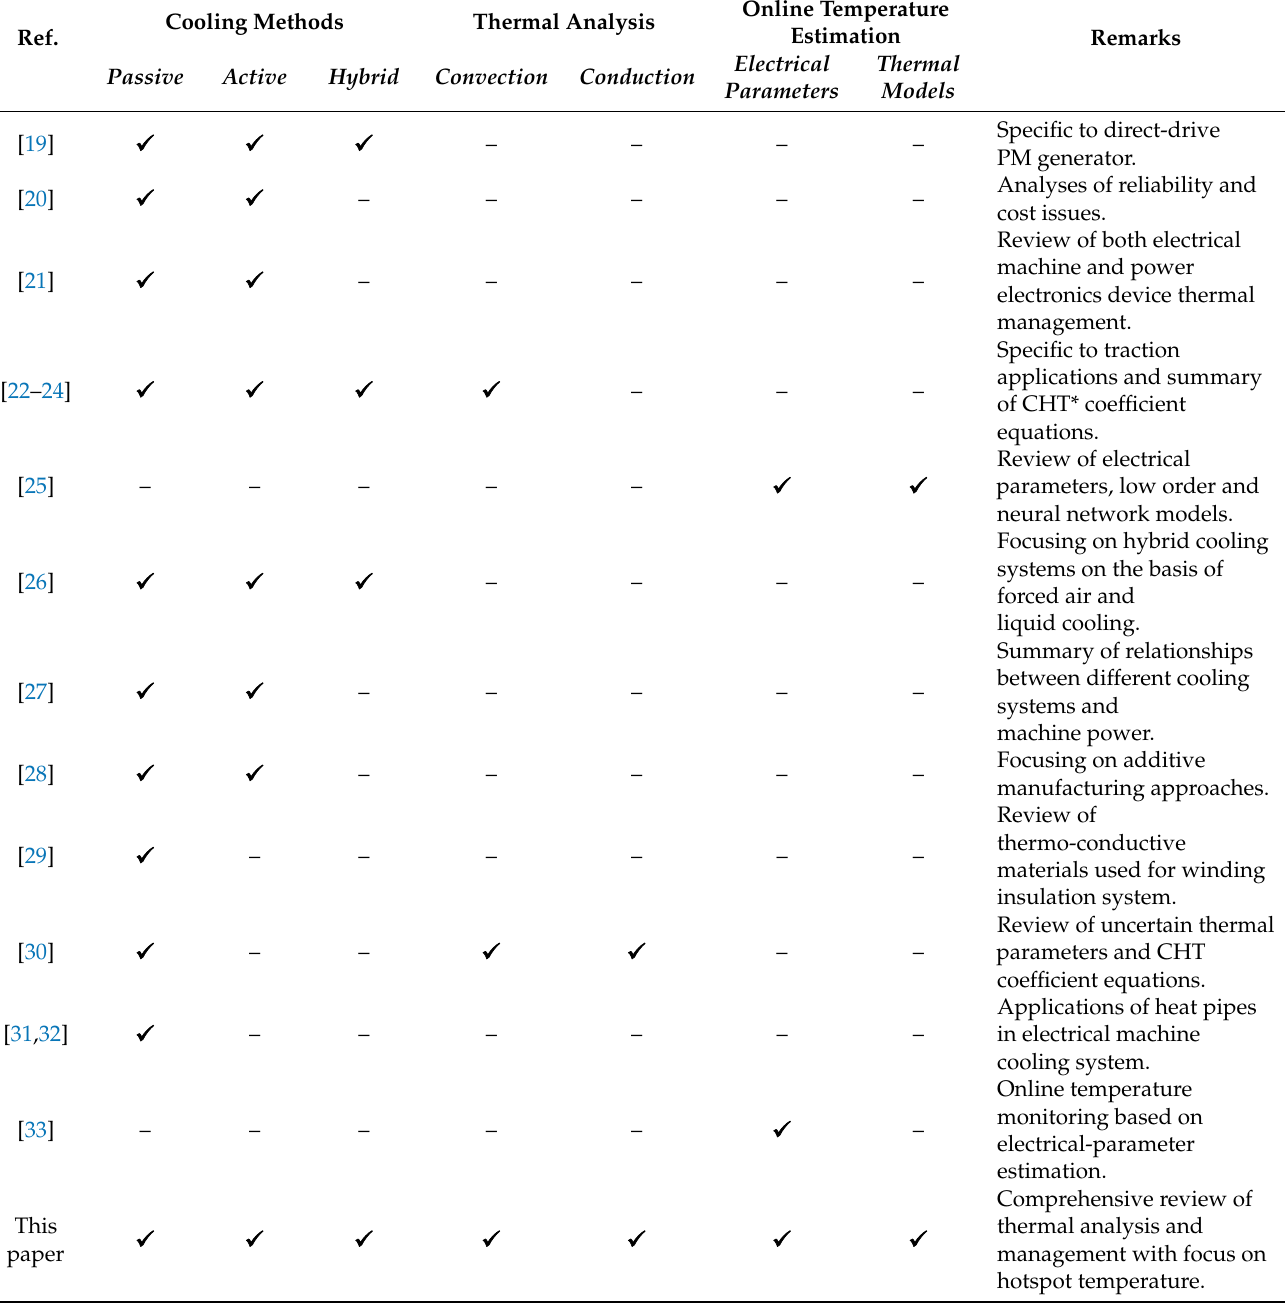
Focusing on hybrid cooling systems on the basis of forced air and liquid cooling.